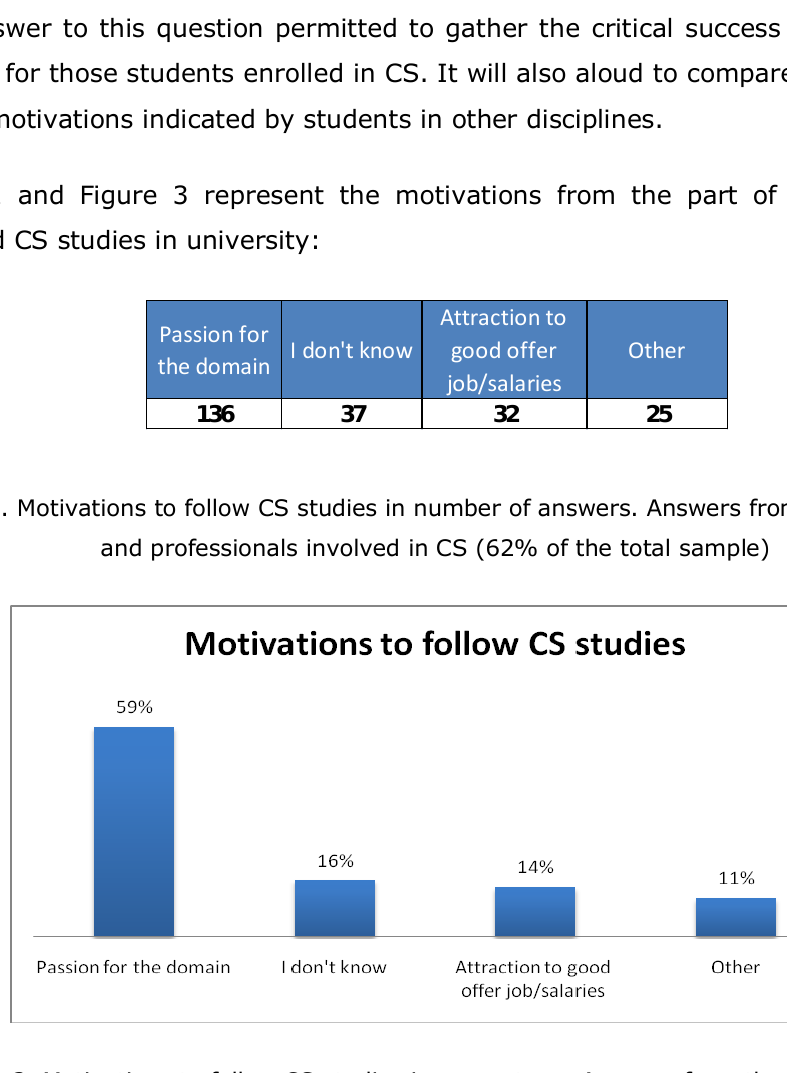
Figure 3. Motivations to follow CS studies in percentage. Answers from the students and professionals involved in CS (Target one: 62% of the total